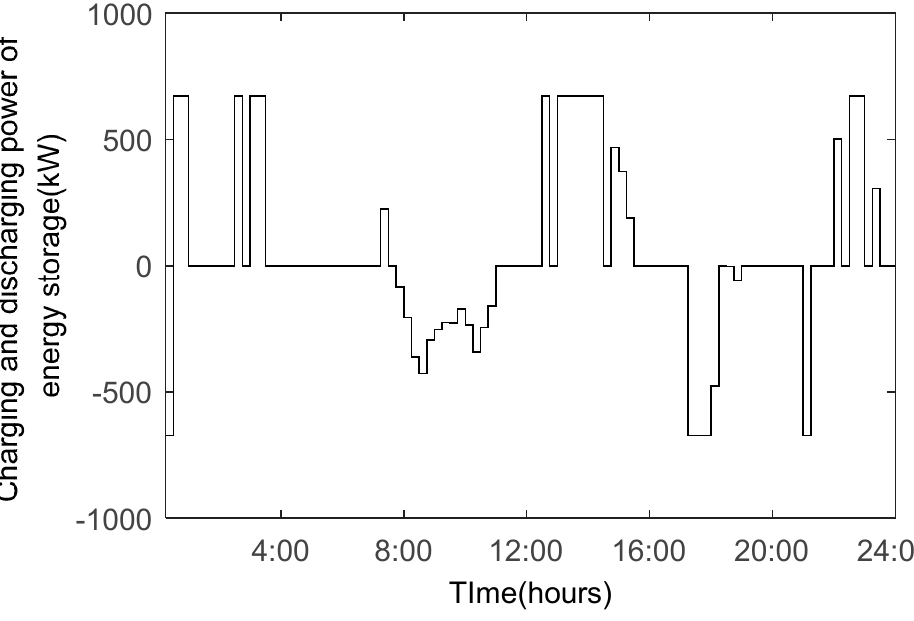
Figure 3. Charging and discharging power of VRLA.